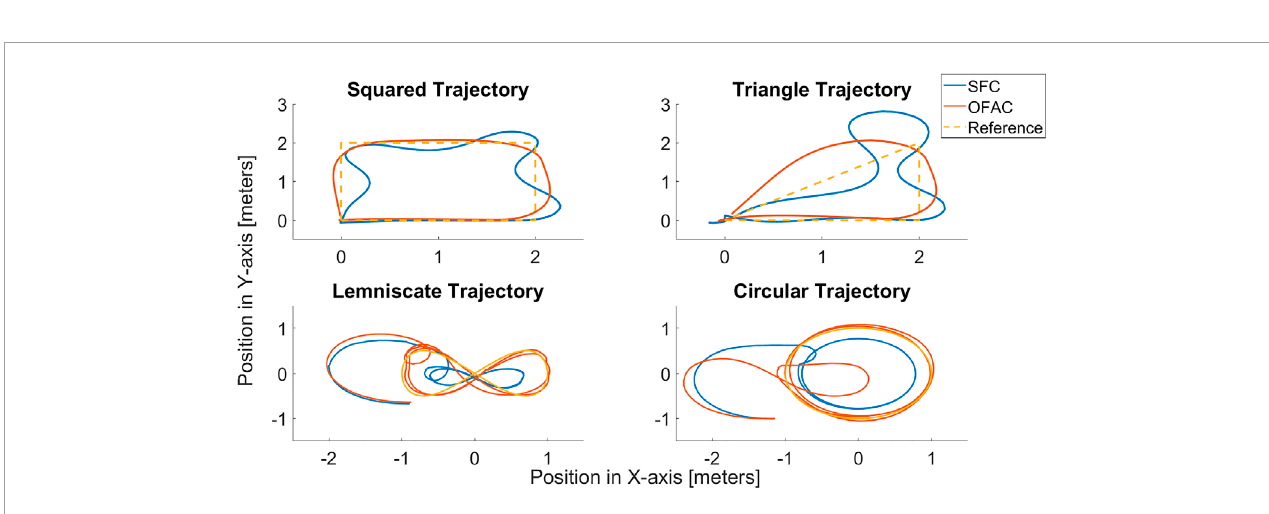
FIGURE 4 SSARP trajectory tracking of different trajectories in the X–Y plane.